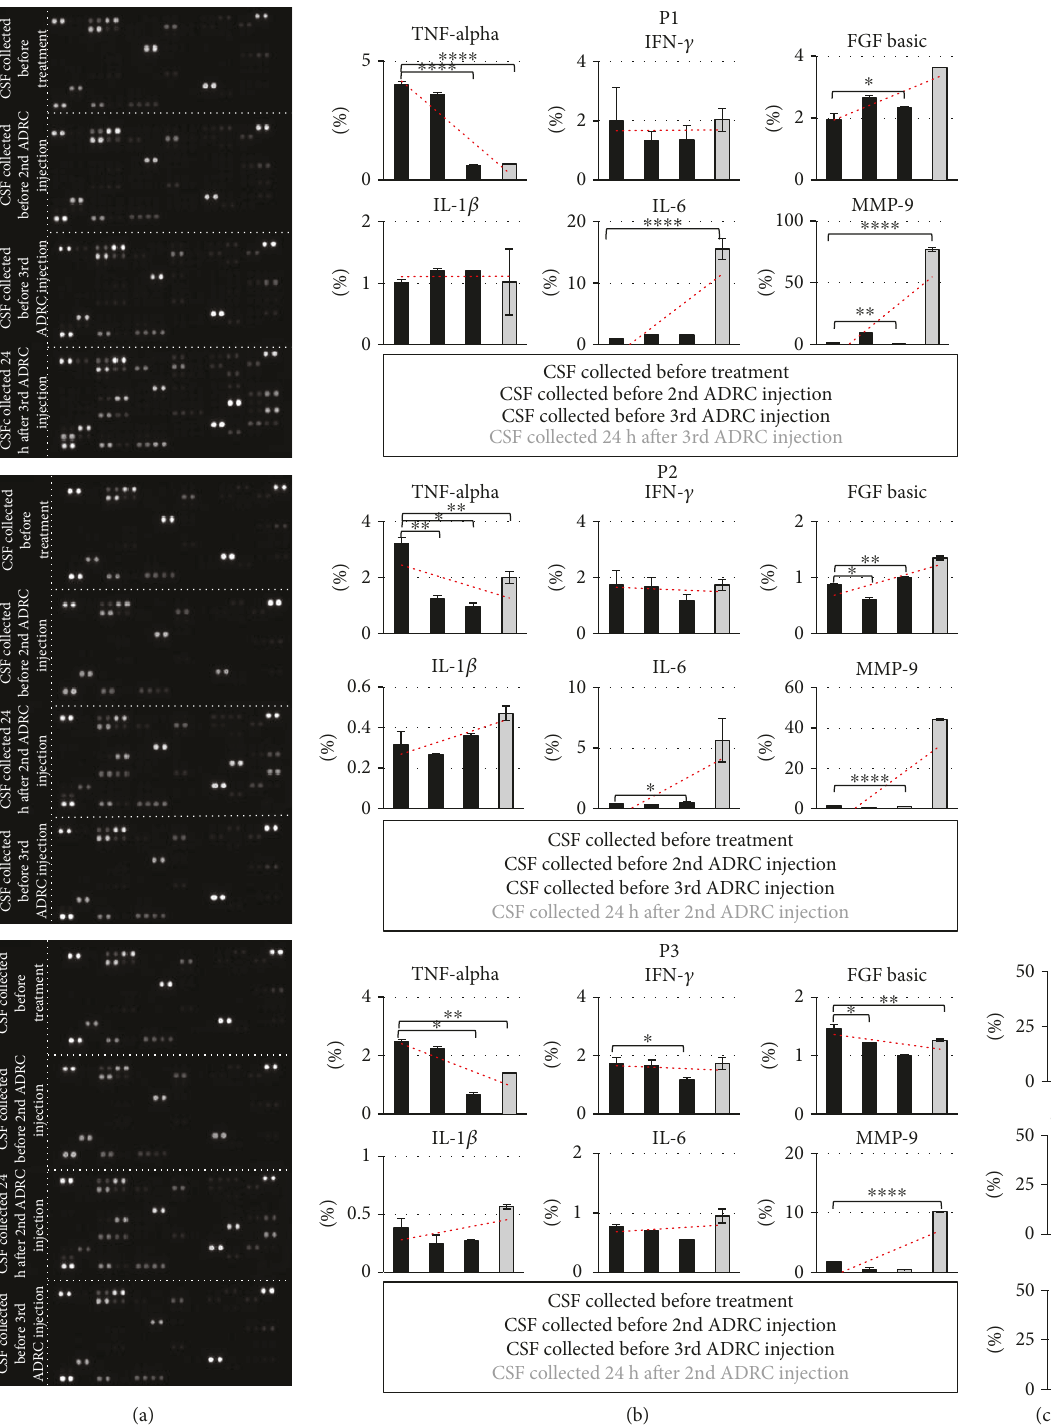
Figure 2: Cytokine and chemokine level in CSF after ADRC application. (a) Membrane-based antibody arrays for the parallel determination of the relative levels of human cytokines and chemokines from CSF of ALS patients (resp. P1, P2, and P3). (b) Comparison of TNF α , IFN- γ , IL-1 β , IL-6, bFGF, and MMP-9 level after MSC transplantation ( black graph bars — 3 months after ADRC application, grey bars — 24 hours after cell application). (c) Quanti fi cation of CFU frequency. ADRCs obtained after enzymatic isolation were analyzed to evaluate the stem cell/ clonogenic population among a heterogeneous stromal cell